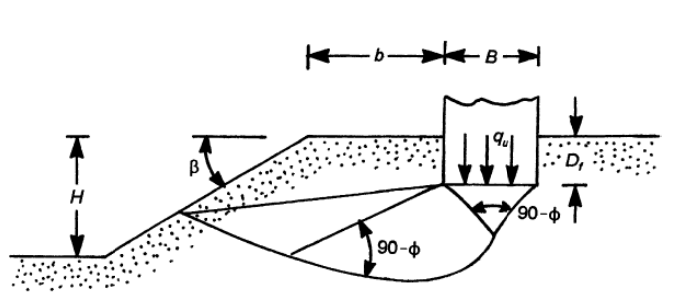
Fig.1 . Shallow foundation near a slope [5]